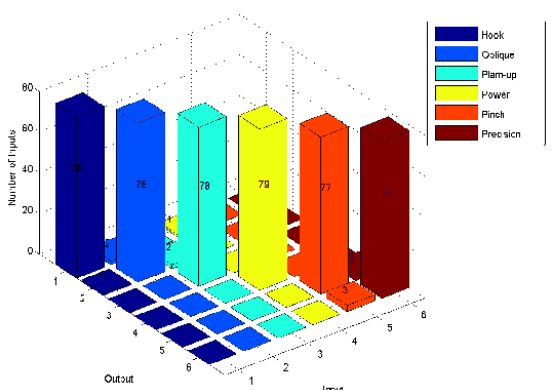
Figure 7. Confusion Matrix for classification based on PCA of Time/ Frequency Domain Features. 80 number of input signals (pertaining to each grasp type) was passed to classifier; Figure shows classification as well as misclassification for each of these signals. Numeric value (on bars) represent the number of signals classified for the particular type